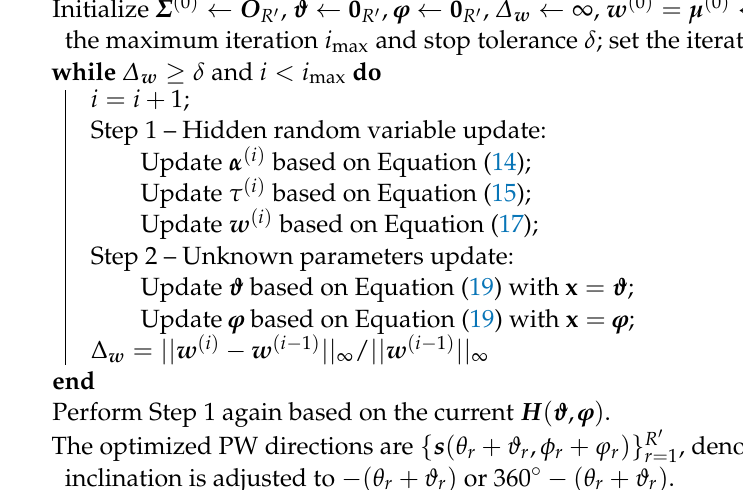
Algorithm 1: Stage 2: Estimation of PWs using parametric SBL (parSBL).